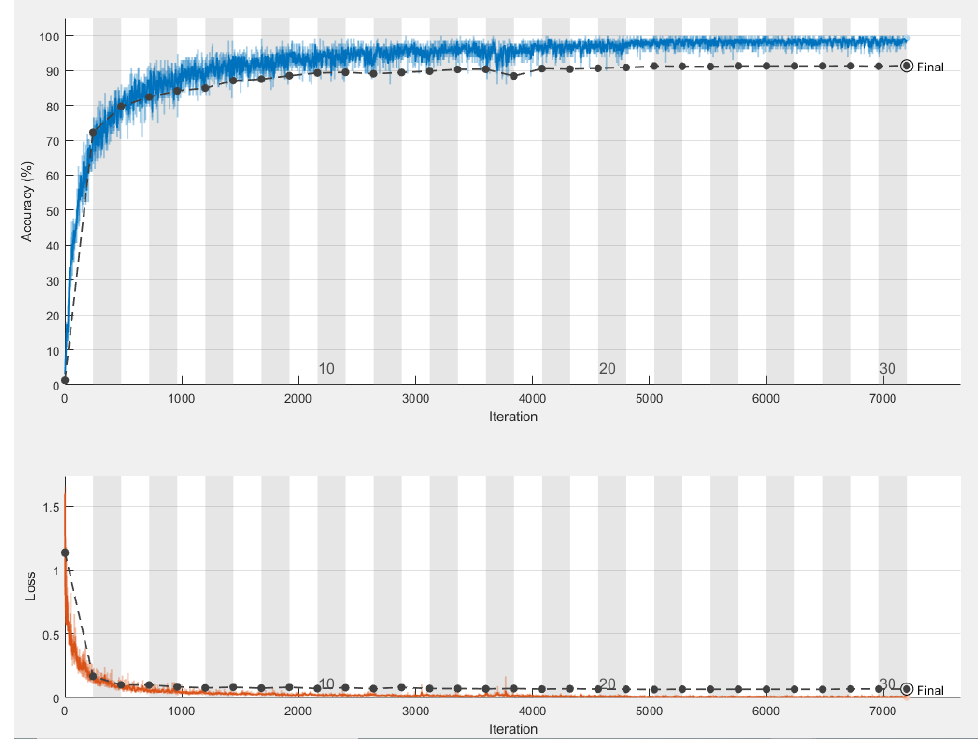
Figure 7. Neural network training